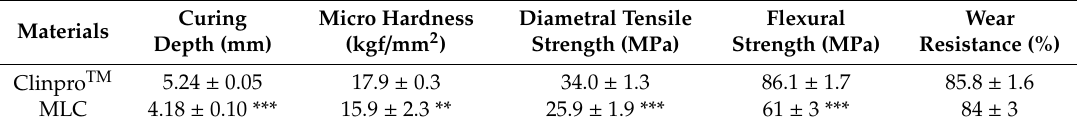
Table 1. Mechanical properties of developed MLC and the commercial product Clinpro TM (n = 10). Curing Micro Hardness Diametral Materials Depth (mm) (kgf / mm 2 )